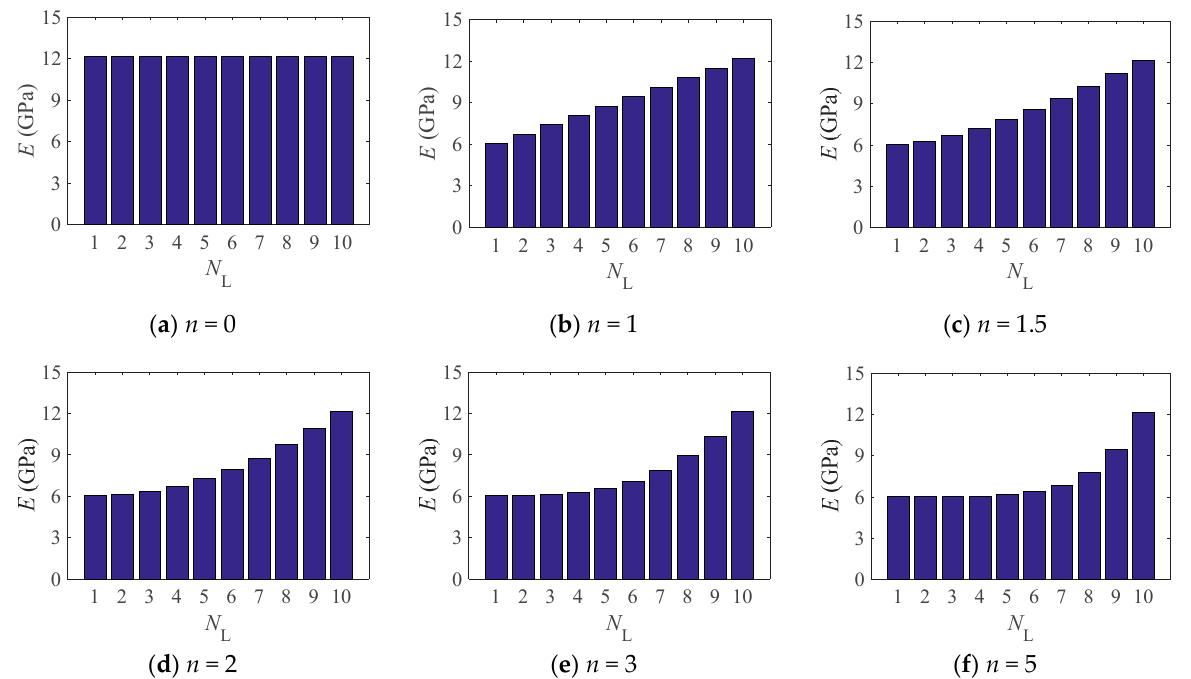
Figure 2. Effective Young’s modulus of an elastically restrained FG-GPLRC arch.